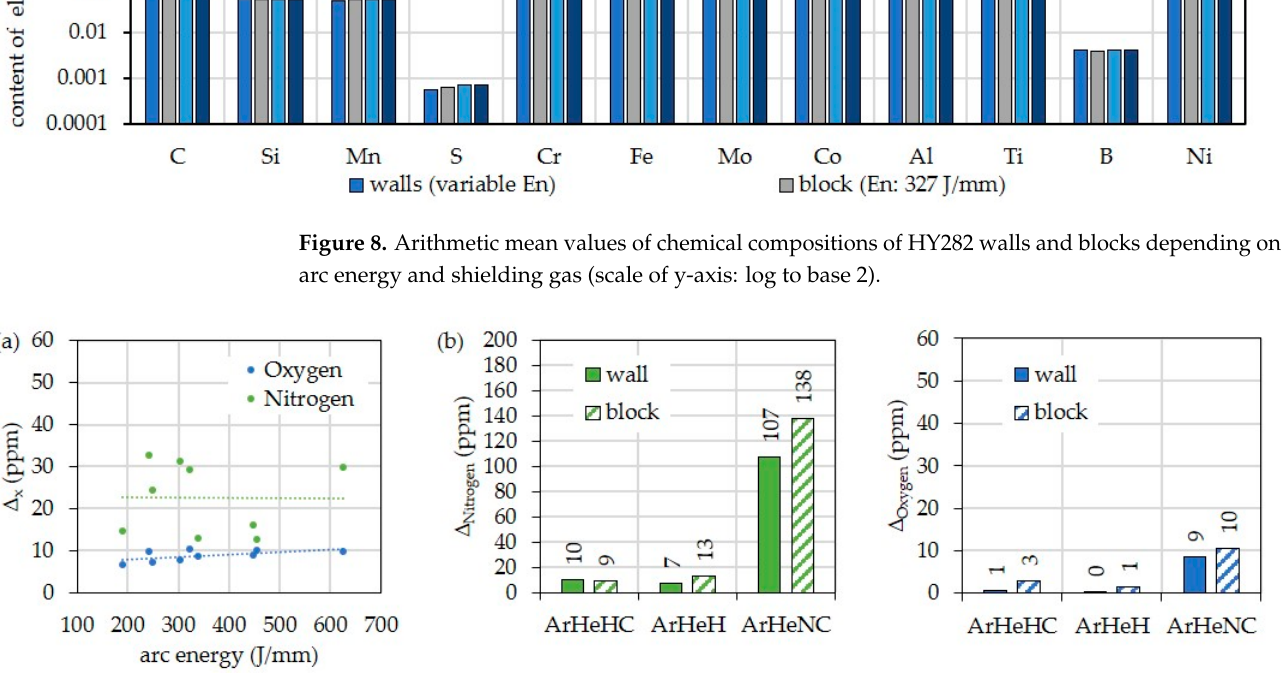
Figure 9. Increase of oxygen and nitrogen in the walls and blocks compared to the wire electrode HY282 depending on ( a ) arc energy ( Φ 0.040 ″ ) and ( b ) shielding gas ( Φ 0.035 ″ ).